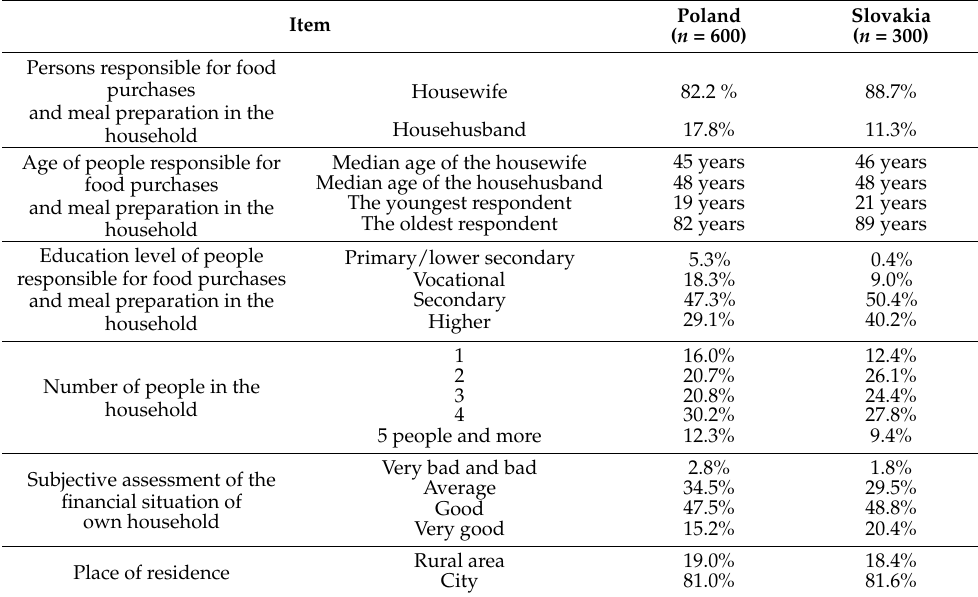
Table 2. Characteristics of the tested sample ( n =